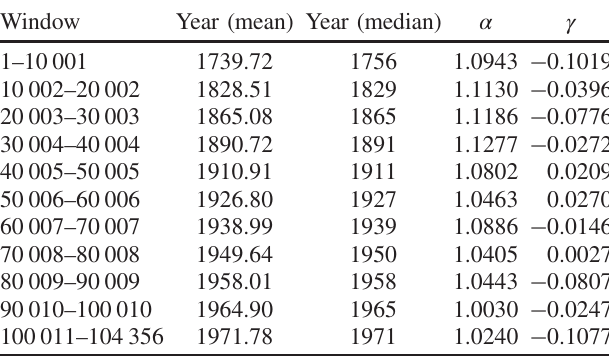
TABLE II. Gravity-model parameters α and γ in Eq. (1) calculated for temporally-divided entries of jokbo 1 by minimiz- ing the sum of squared differences using the SCIPY . OPTIMIZE package in P YTHON [35]. (We again use initial values of α ¼ γ ¼ a 1 . 0 in these computations.) We sort the list of brides G ¼ according to birth year, (temporally) partition the data such that each time window (except for the last one) has 10 001 entries, and indicate the mean and median birth year in each window.